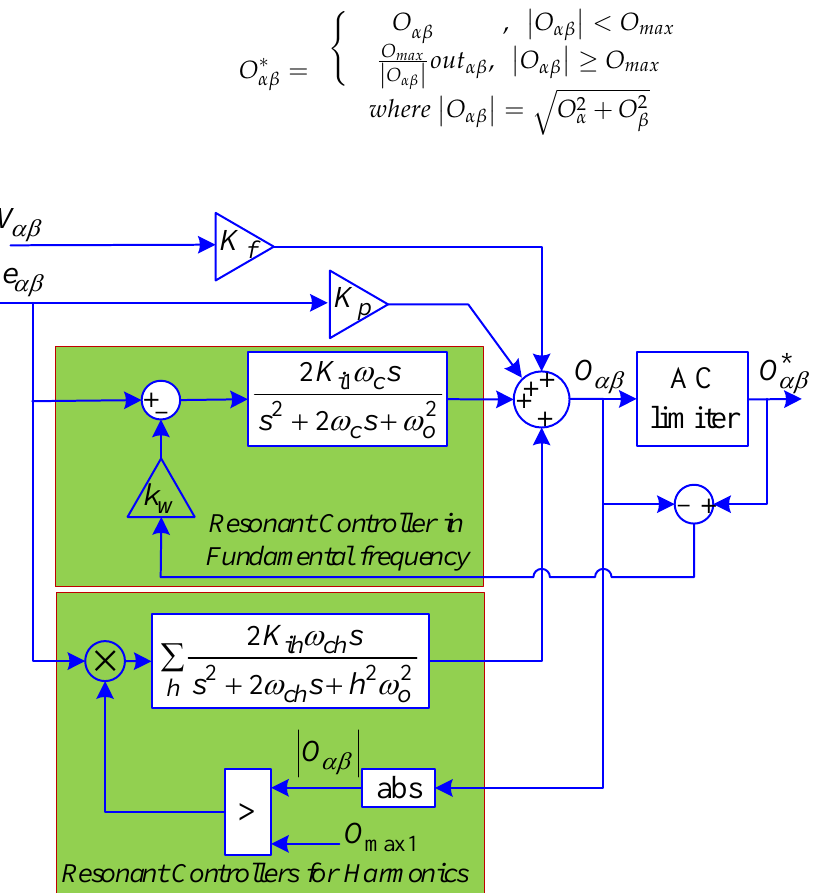
Figure 9. PR controller with the anti-wind-up capability and harmonic compensation capability in the inner current loop.